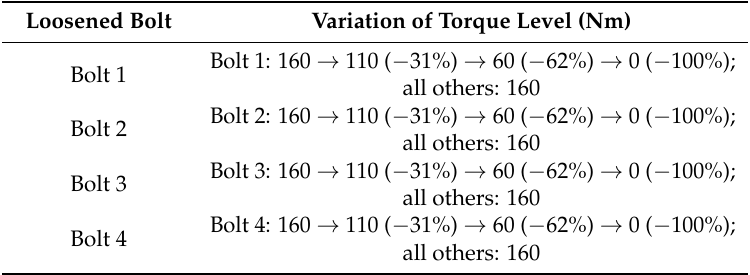
Table 5. Preload change cases of bolted girder connection.